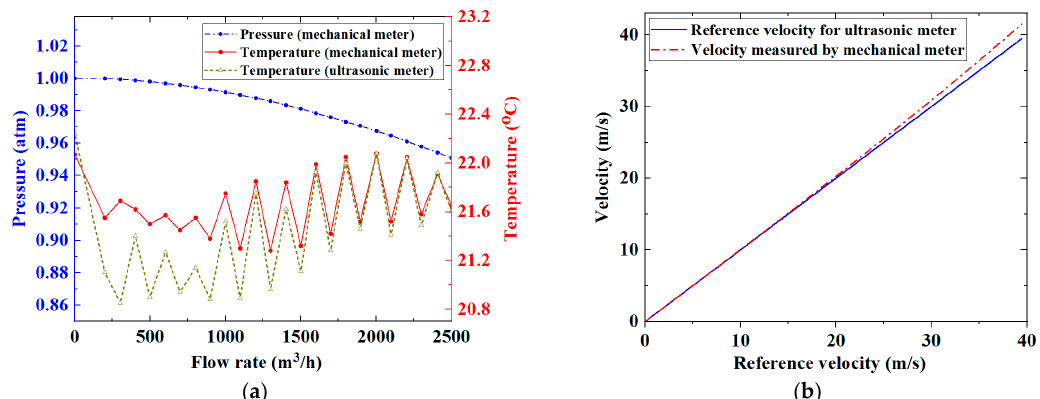
Figure 4. The prototype for the ultrasonic flow meter, where the control system digitizes, records, and processes the ultrasonic signals.